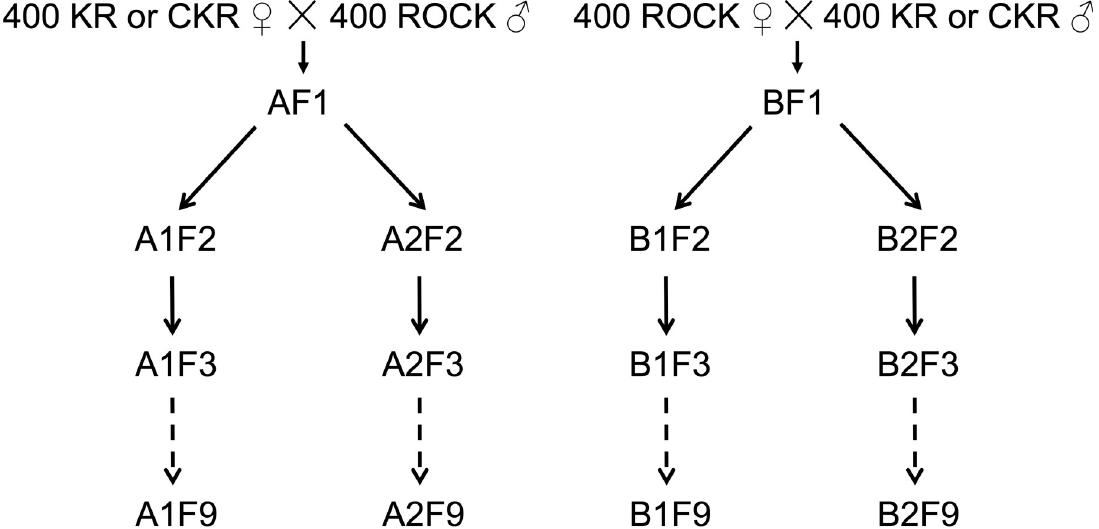
Fig 1. Allele-competition reciprocal (A and B) crosses. Two separate experiments were conducted: one crossing KR with ROCK and one crossing CKR with ROCK. Both experiments were maintained for nine generations.